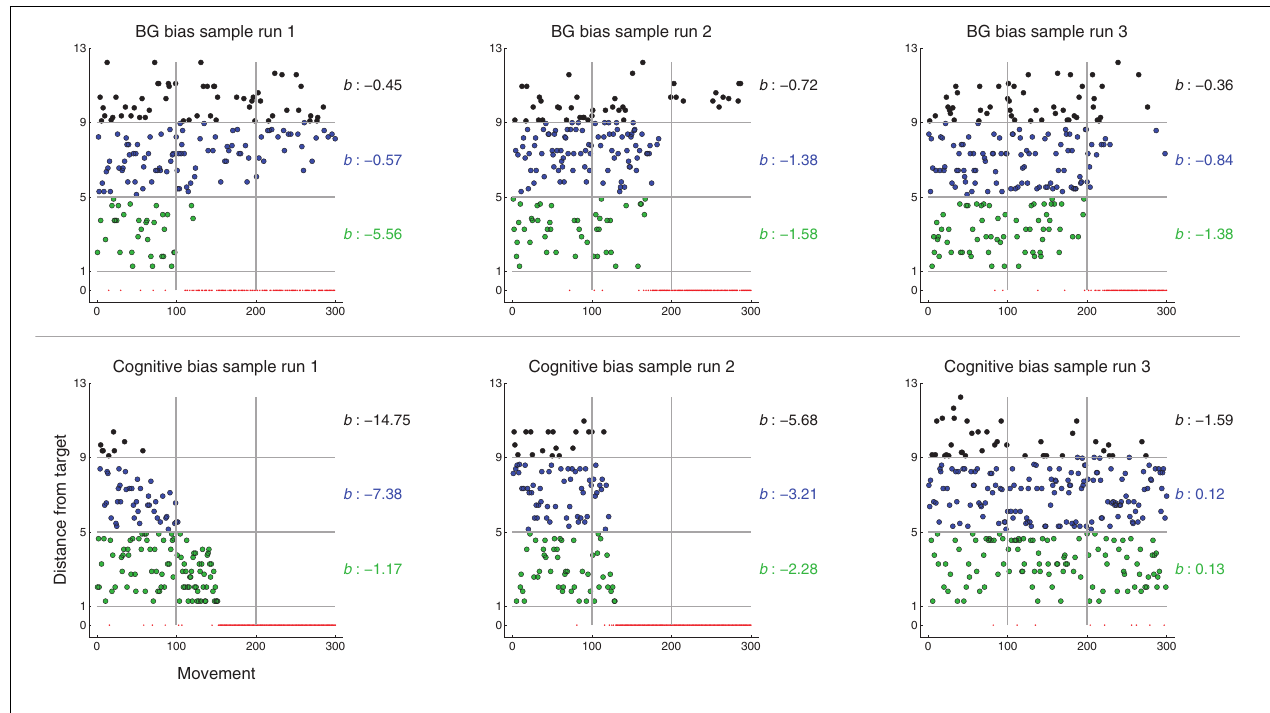
FIGURE 10 | Distance from G 1 of executed movement (in units of θ G ) as a function of movement number (similar to Figure 5, right) for sample runs of models using BG-mediated biasing (top row) or Cognitive biasing (bottom). Color of dot indicates the spatial zone (defined relative to